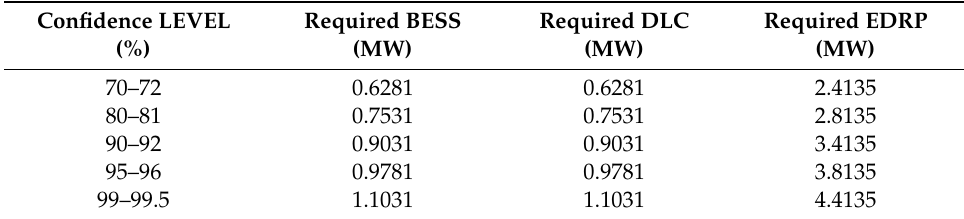
Figure 15. Probability distribution of the required BESS power output. Table 10. The comparison of capacity